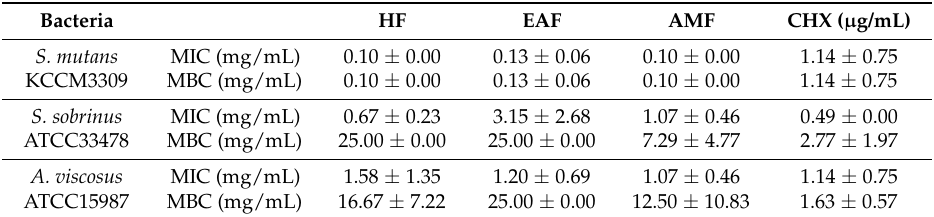
Table 6. Minimum inhibitory concentration (MIC) and minimum bactericidal concentration (MBC) of P. cubeba L.